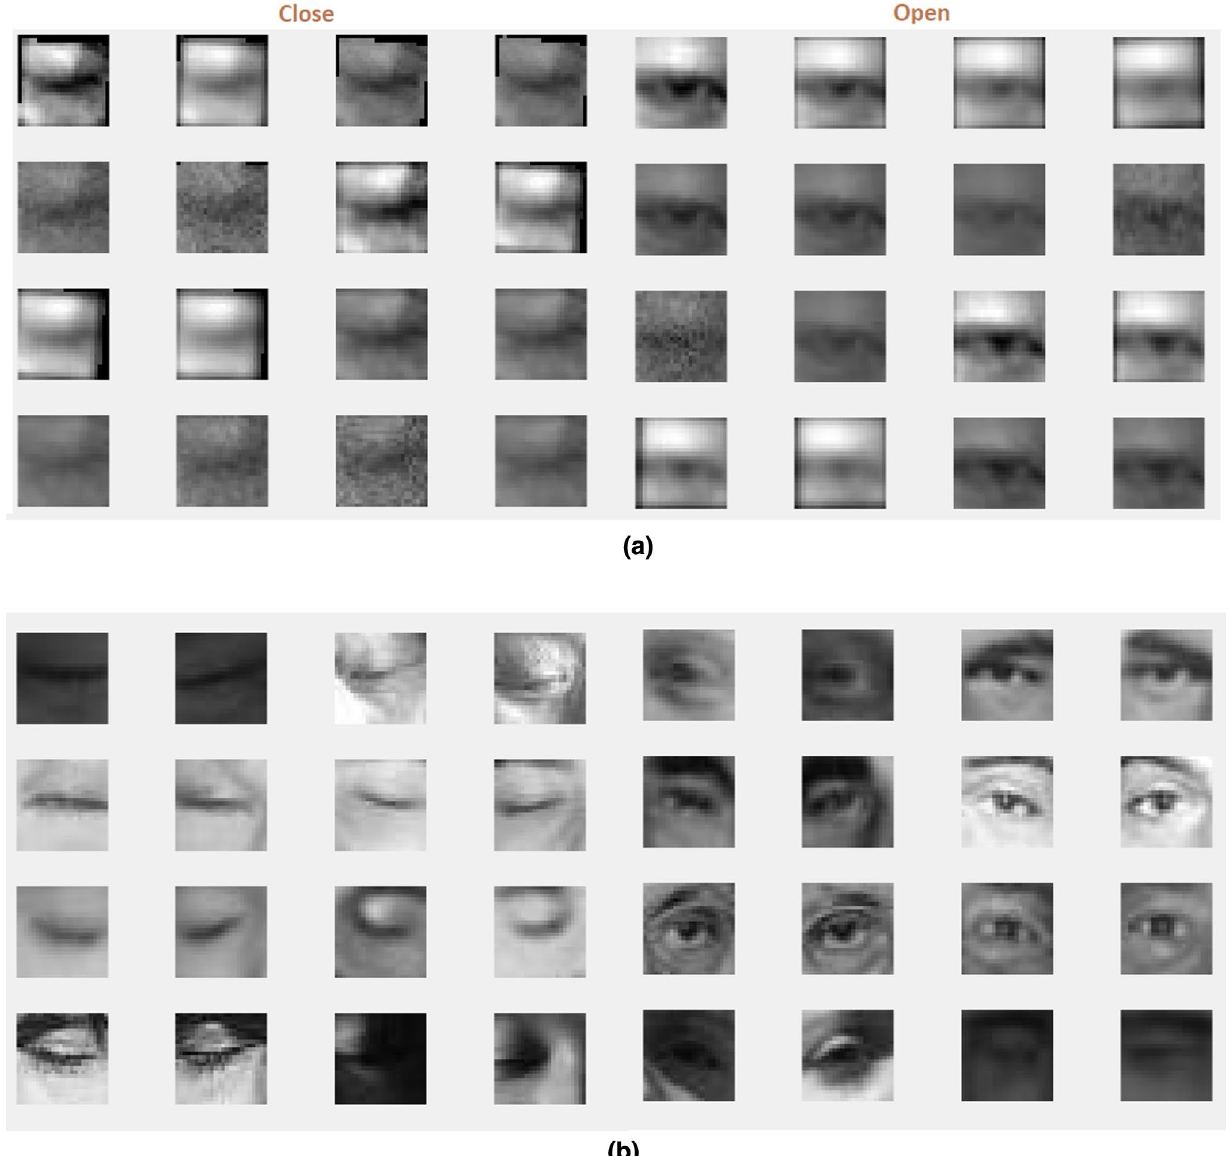
Fig. 4 Open and closed sample eye images in datasets: a ZJU and b